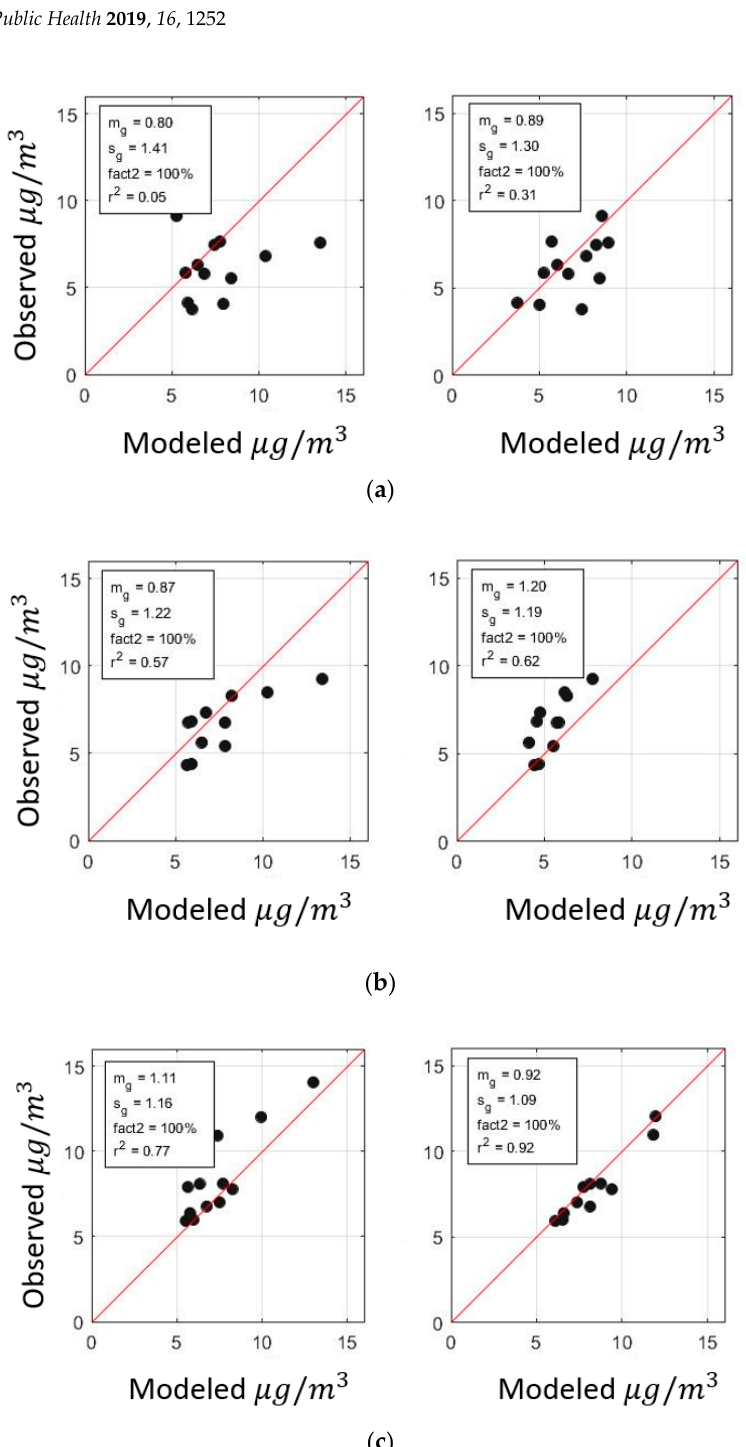
Figure 14. Cross-validation using simple Kriging model (left panels) and residual Kriging (right panels) at ( a ) Westmorland, ( b ) Seeley, and ( c ) Holtville.